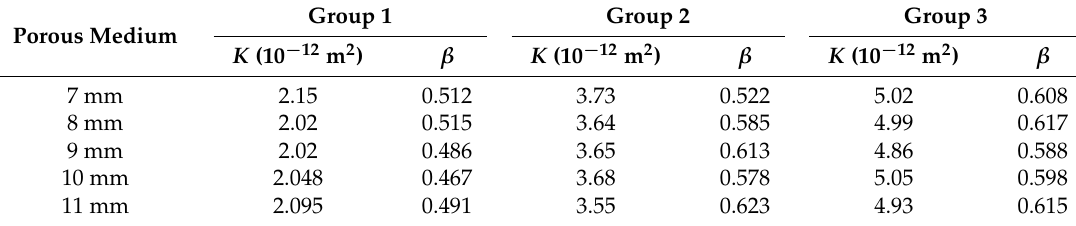
Figure 11. Permeability obtained by the discharge method in different pressure subsections for the five porous media of group 2. Table 3. Permeability and inertia coefficients of the porous media by the steady-state method.